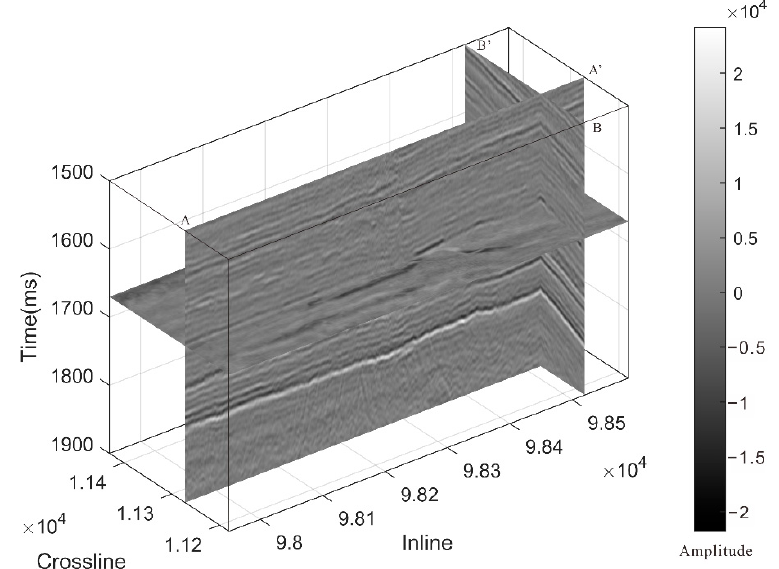
Figure 3. The 3D view of the field seismic dataset. AA’ and BB’ are through-well seismic profiles.